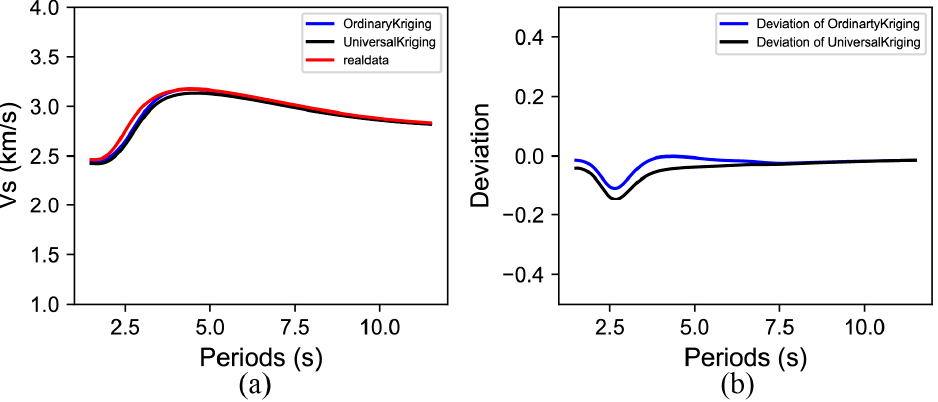
Figure A6. Comparison of dispersion curve interpolation results (128.18° E, 41.82° N ). The blue curve indicates the ordinary kriging results, while the black curve indicates those of universal kriging: ( a ) Comparison of the dispersion curves; and ( b ) deviation of the OK (blue) or UK (black) results.